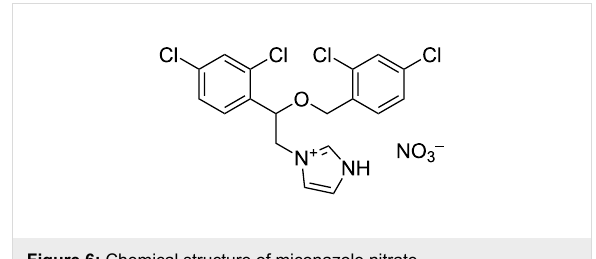
Figure 6: Chemical structure of miconazole